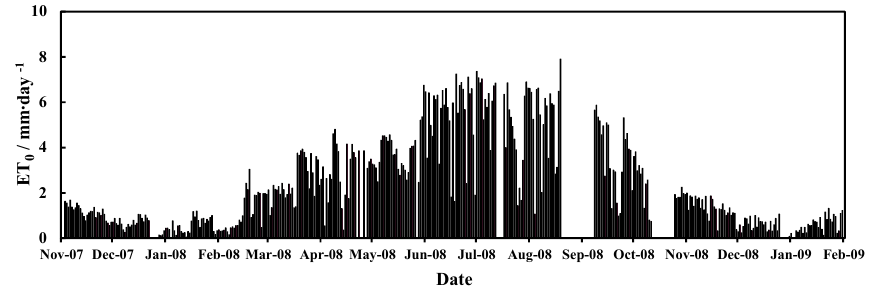
Figure 8. Daily reference evapotranspiration ( ET 0 ) at the Yingke site from November 2007 to January 2009.